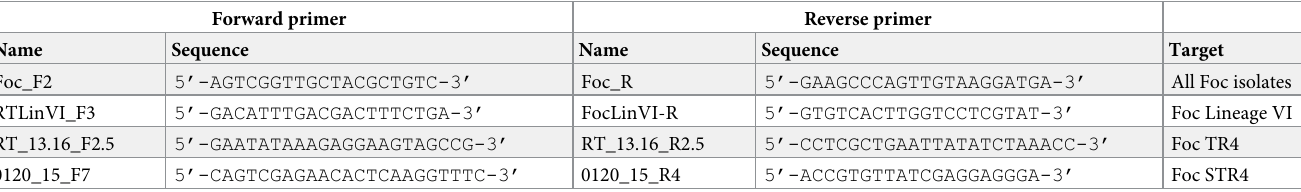
Table 2. Primer names, sequences and target Fusarium oxysporum f. sp. cubense (Foc) groups. Forward